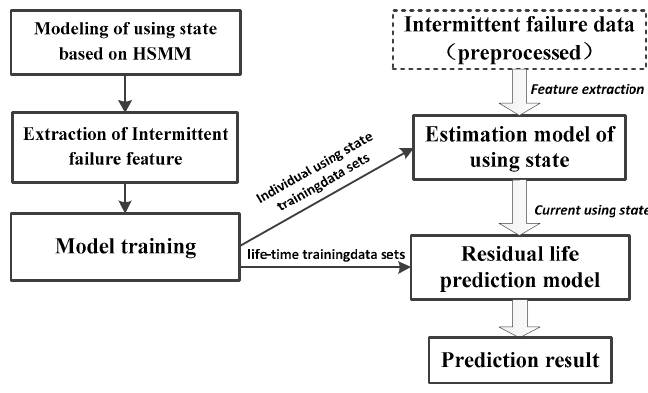
Figure 8. Overall scheme of residual life prediction for electrical connectors.